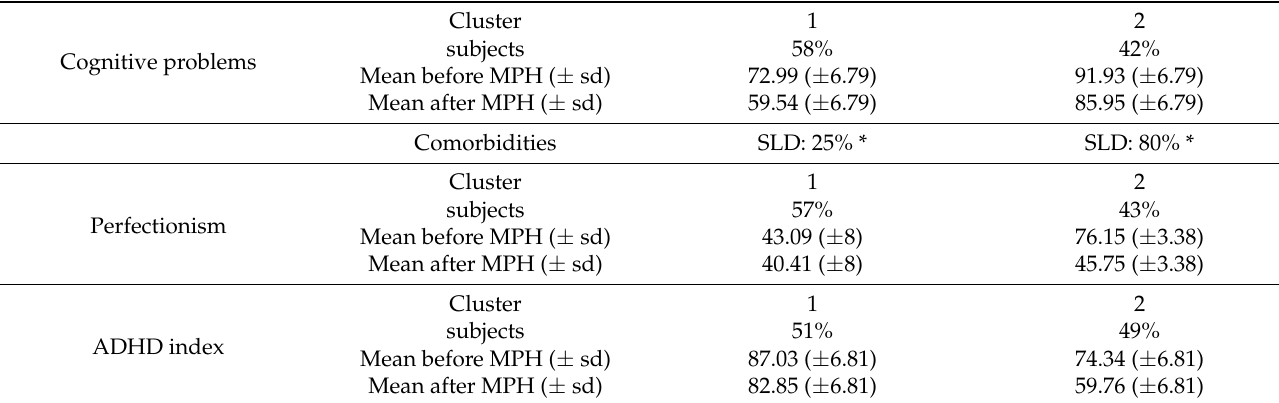
Table 3. CPRS-R clusters